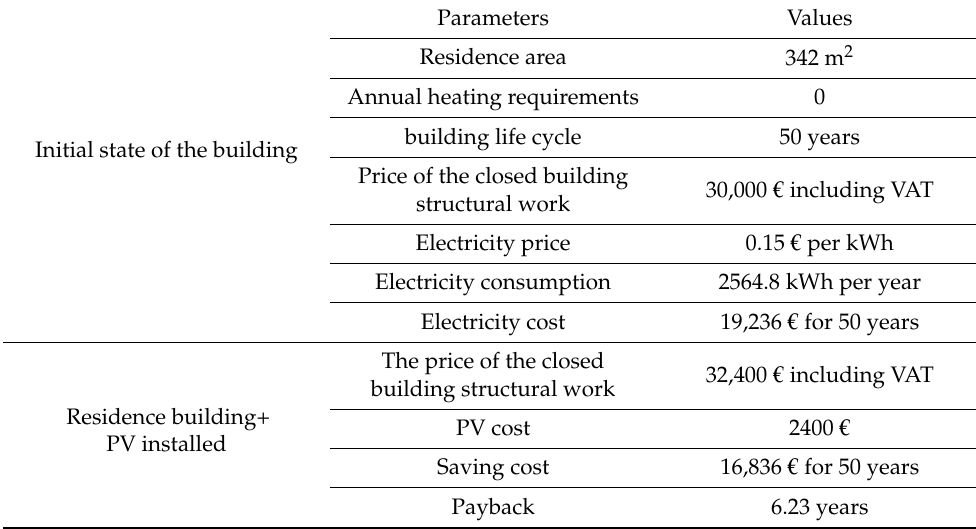
Table 9. Evaluation of residential building